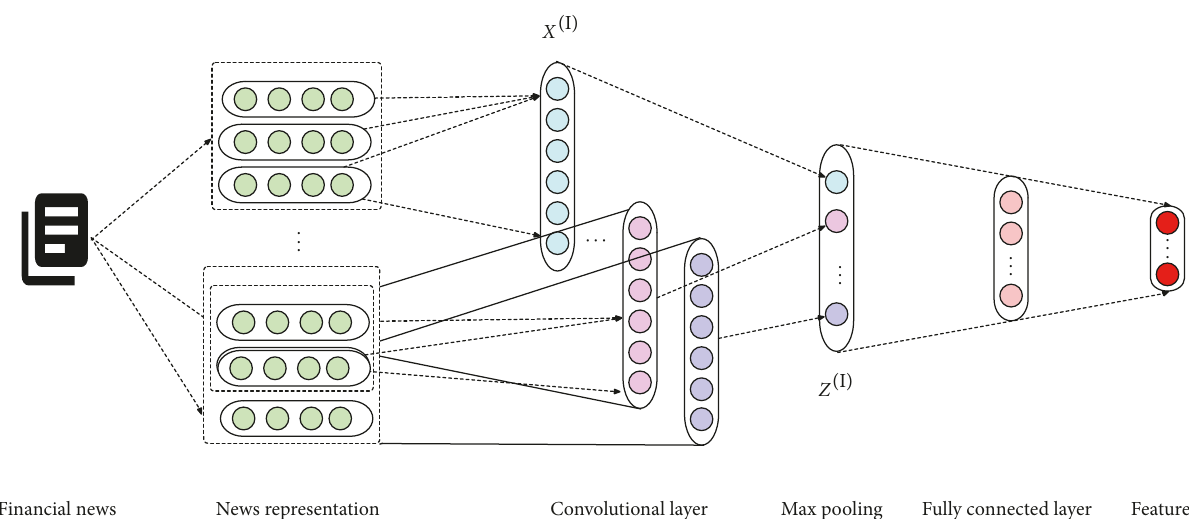
Figure 3: Convolutional neural network architecture proposed for feature